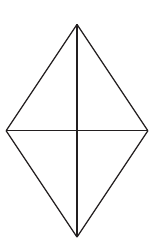
Figure 3: Example of conforming mesh in R 2 .